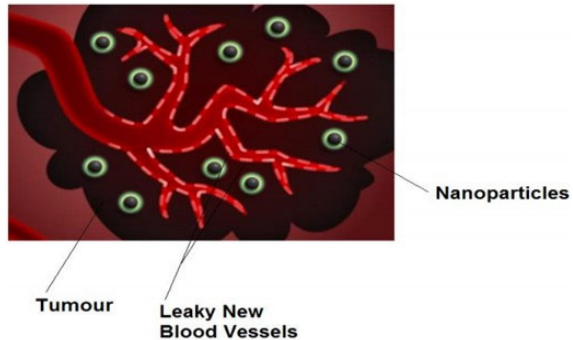
Figure 3. Accumulations of nanoparticles in tumor.